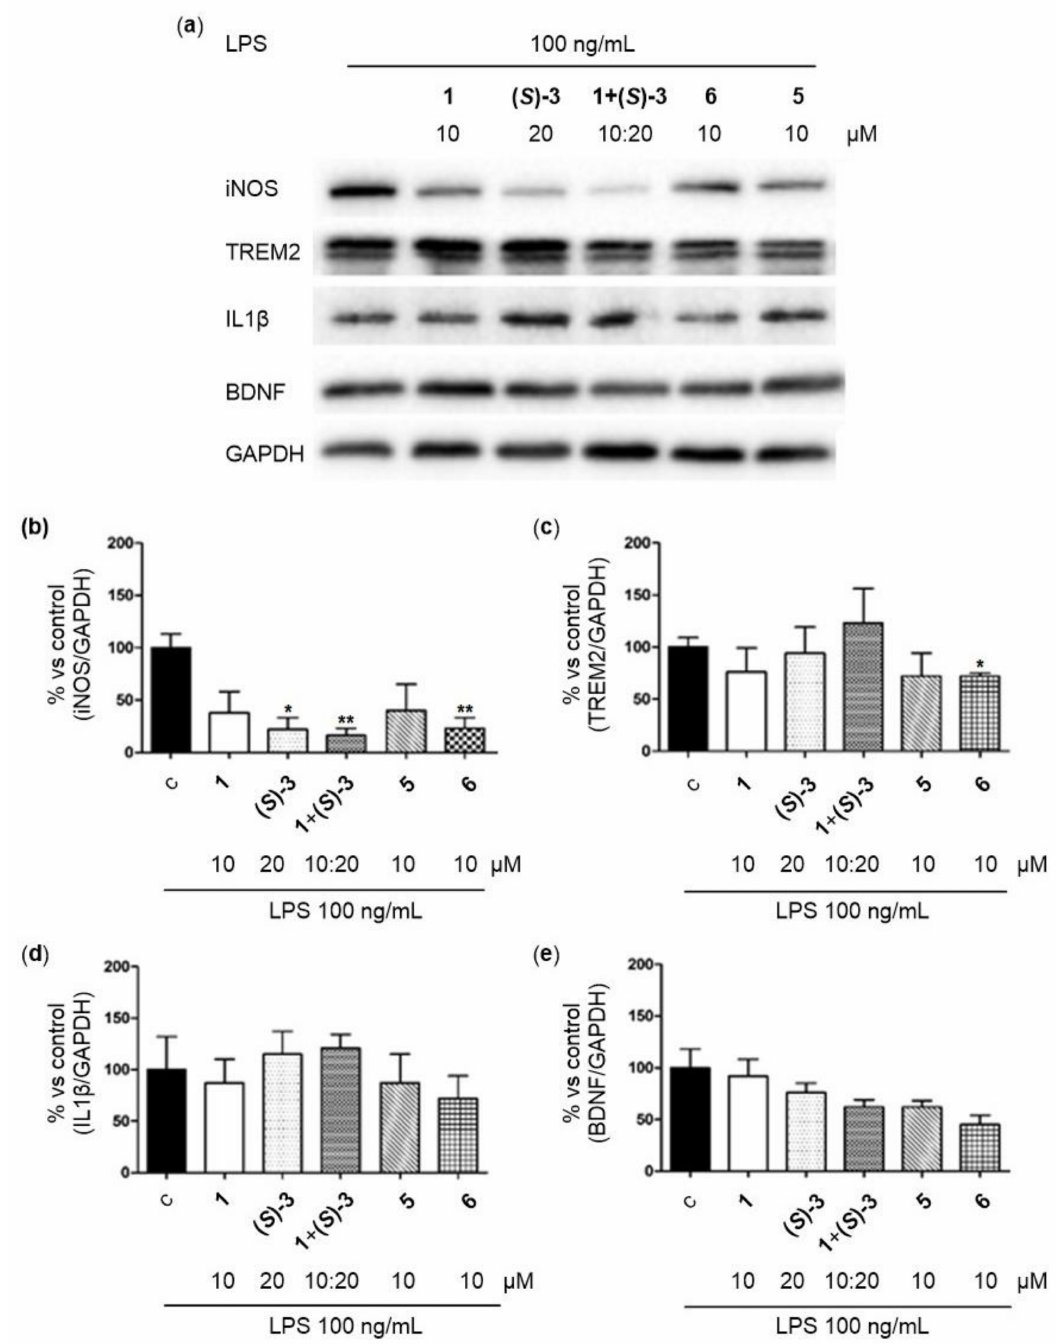
Figure 5. Immunomodulatory effects of conjugates 5 and 6 and reference compounds. Immortalized microglia cells (N9) were exposed to lipopolysaccharide (LPS) and the respective tested compound for 24h; then inducible nitric oxide synthase (iNOS), triggering receptor expressed on myeloid cells 2 (TREM2), interleukin 1 β (IL-1 β ) and brain-derived neurotrophic factor (BDNF) expression was assessed through Western blot analysis ( a ) and relative densitometries of iNOS ( b ), TREM2 ( c ), IL-1 β ( d ) and BDNF ( e ) expressions. GAPDH was used as loading control. Densitometric results are expressed as percentage of LPS only and are the mean ± SE of three different experiments. * p < 0.05 ** p < 0.01 compared to LPS condition, Student’s t test after